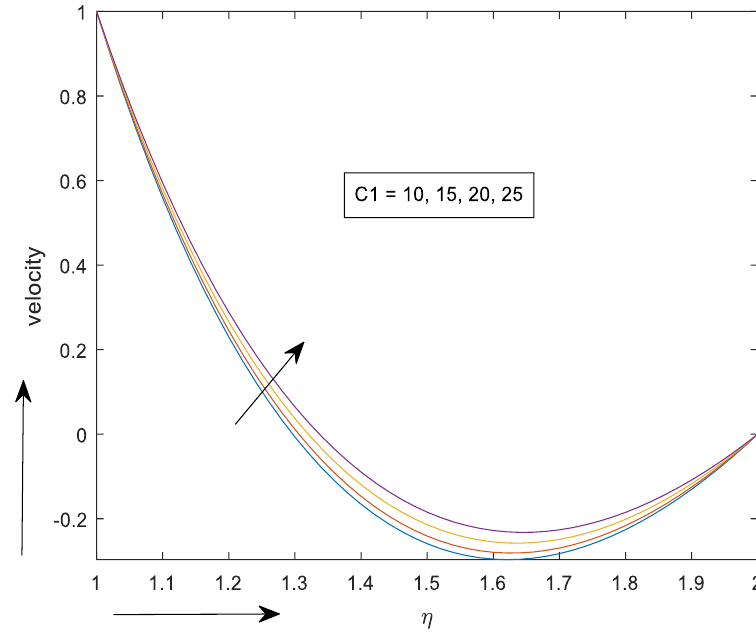
Figure 1. Velocity profile for different values of 𝐶